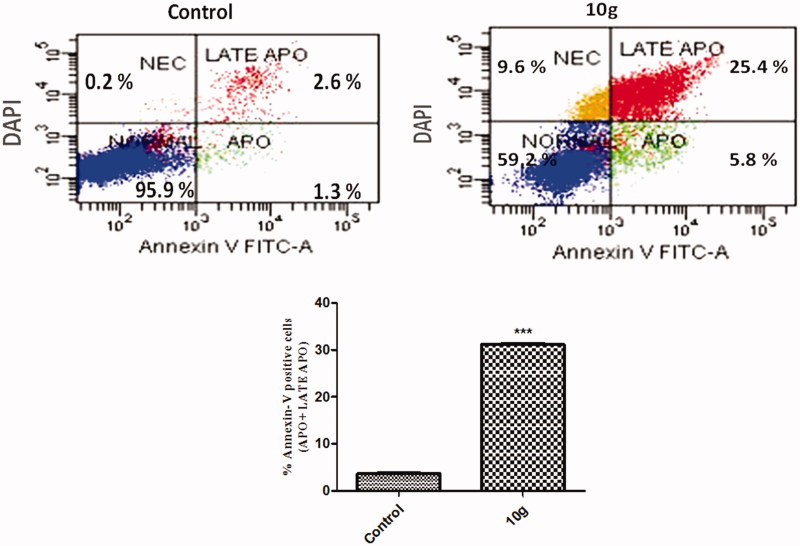
Effect of compounds 10g on the percentage of Annexin V-FITC-positive staining in MDA-MB-231 cells versus control (1% DMSO). Data are mean ± SD (n = 3). The experiments were done in triplicates. The four quadrants identified as: Normal, viable; Apo, early apoptotic; LATE APO, late apoptotic; NEC, necrotic. ***Significantly different from control at p < 0.001 (student’s t-test).